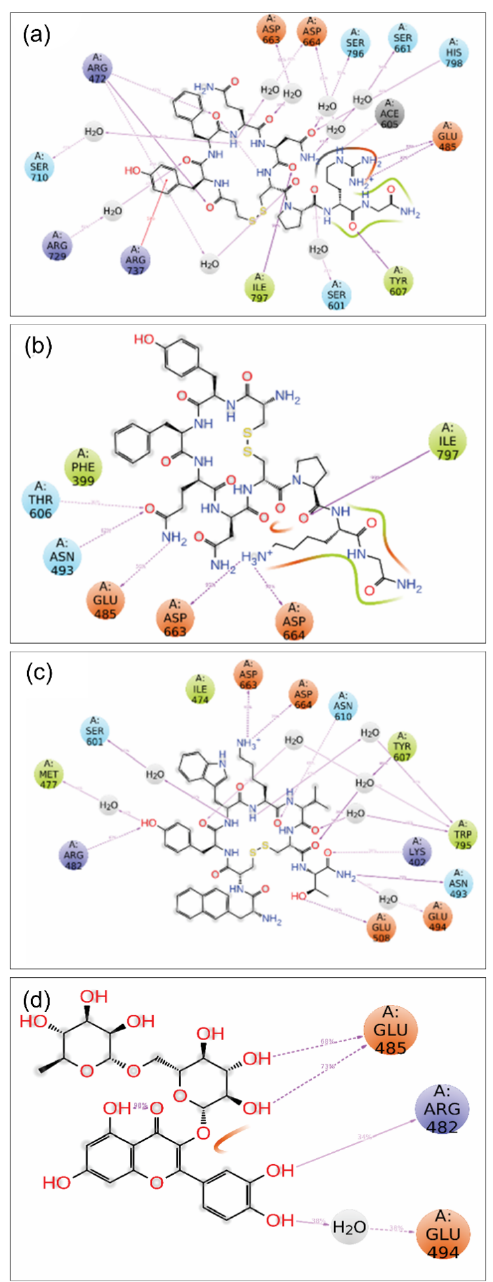
Figure 7. The 2D interaction diagrams of protein–ligand interaction maps for dengue RdRp with selected drug compounds—( a ) desmopressin, ( b ) rutin, ( c ) lypressin, and ( d ) lanreotide—extracted from the total 100 ns MD simulations.